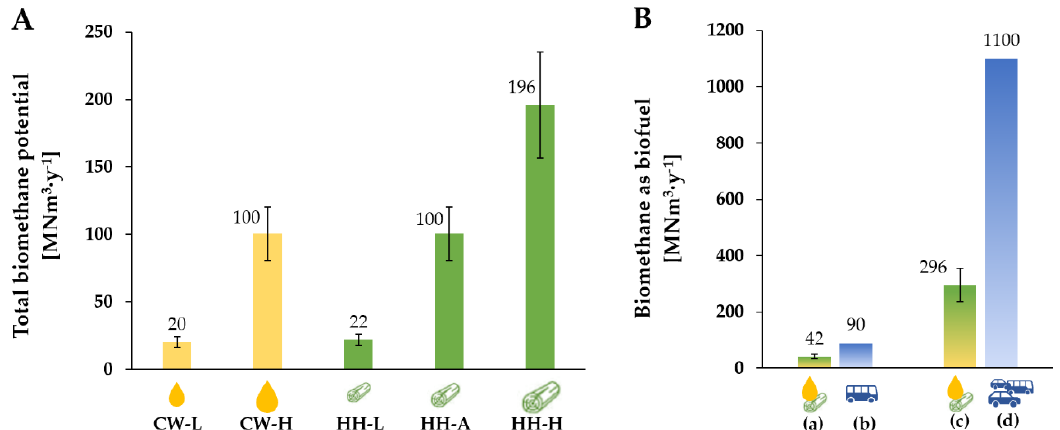
Figure 4. ( A ) Total biomethane potential from the current surplus cheese whey (CW) and the possible future hemp hurds (HH) available in Italy. ( B ) Comparison between the methane produced biologically from CW and HH and the current Italian natural gas demand as transportation fuel. Letters (a) and (c) in panel B indicate the low (CW-L + HH-L) and high (CW-H + HH-H) combined biomethane potential of CW and HH, conservatively calculated without considering the potential synergistic effect of coAD. Letters (b) and (d) indicate the annual natural gas demand in Italy for public transportation alone (b) and public and private transportation together (d). The bars in both panels indicate a range of total biomethane potential based on a ±20% variability of the CW and HH BMP values obtained in this study.